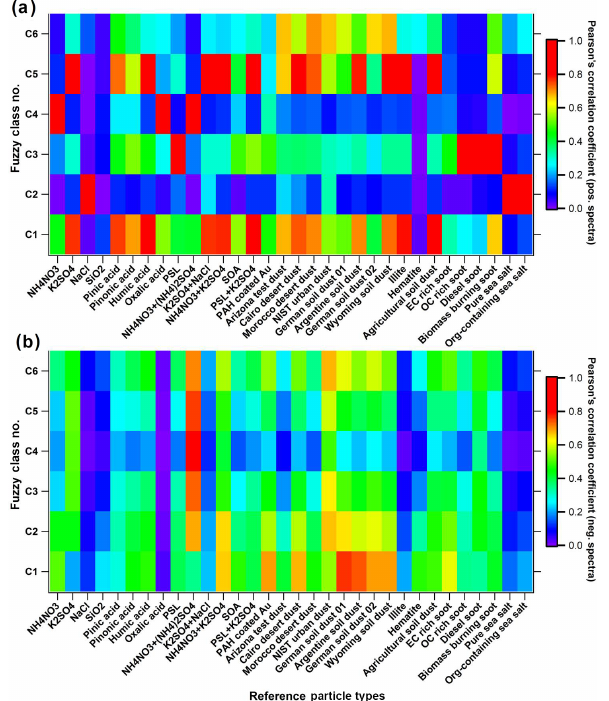
Figure 9. Correlation between fuzzy classification results (6 classes, C1 to C6) and laboratory-based reference spectra. (a) and (b) are the correlation results for the positive and negative spectra, respectively. PAH is short for poly(allylamine hydrochlo- ride); biomass burning soot is the lignocellulosic char from chestnut